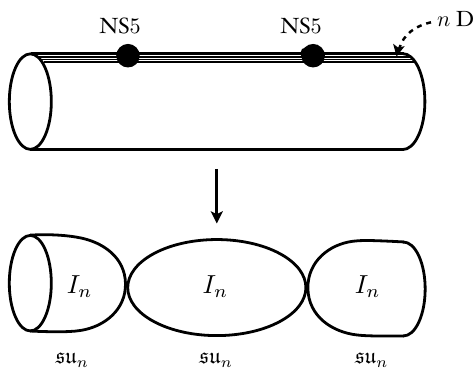
Figure 3 . NS5-branes, D6-branes, and T-duality. The compact and noncompact directions of the cylinder are called respectively directions 4 and 3 in the